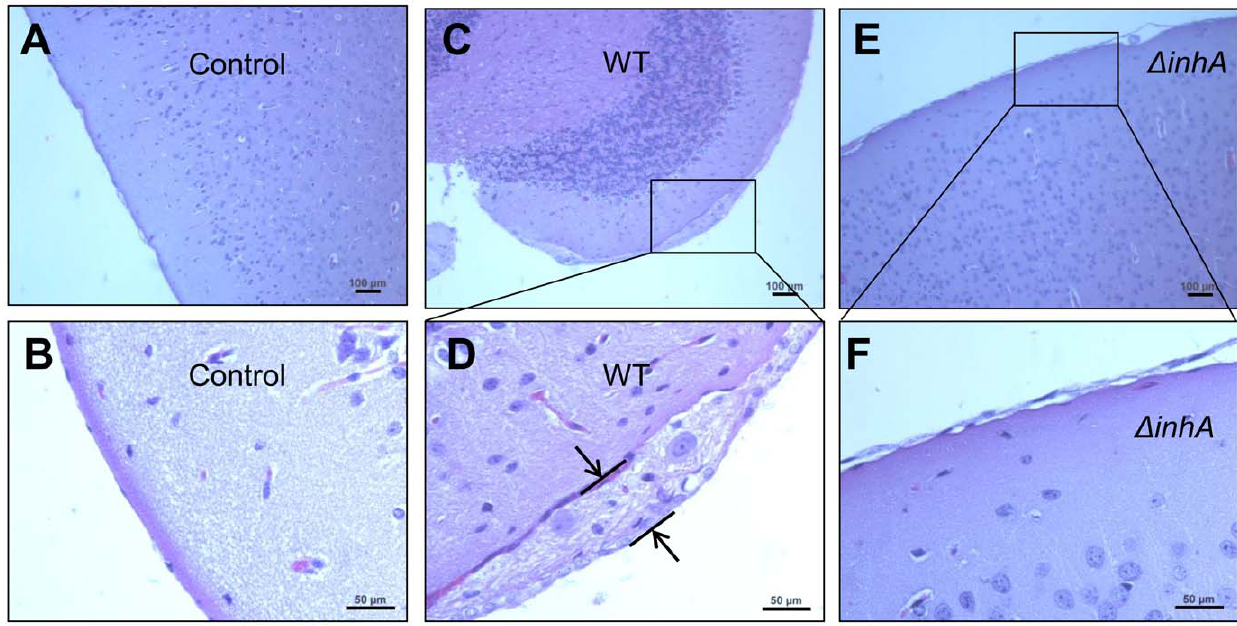
Figure 7. InhA contributes to BBB breakdown during B.anthracis infection in mice. Histopathology of representative H&E-stained brain sections from mice challenge as in Figure 6. (A, B) Control mice; (C, D) Moribund mice challenged with B. anthracis Ames 35. Meningeal thickening is shown by double arrows. (E, F) Moribund mice infected with B. anthracis D inhA . Boxes in C, E show the areas enlarged in D, F, respectively.